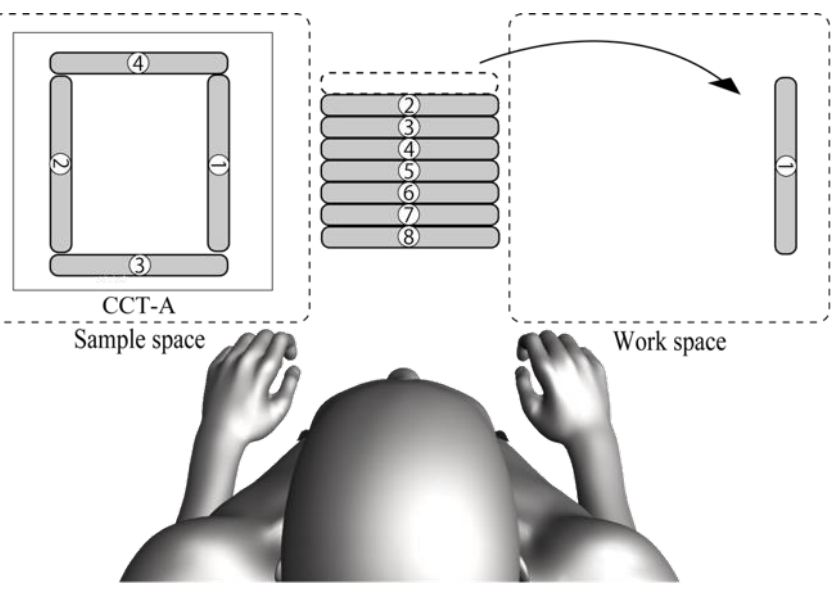
Figure 3. Experimental set-up for CCT-A.